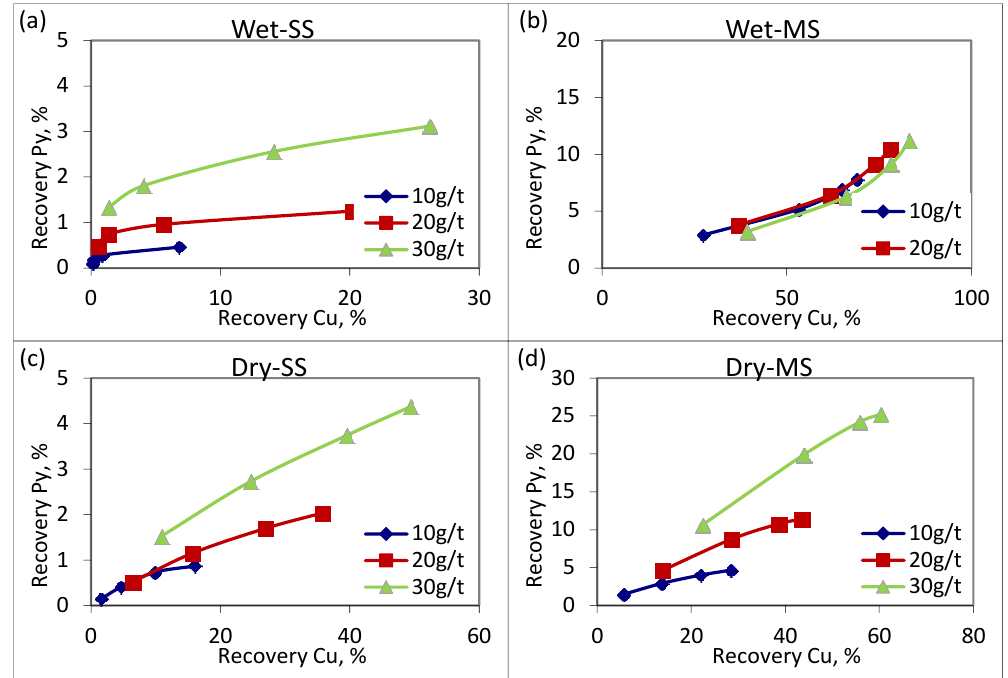
Figure 6. Pyrite vs. copper recovery in flotation after milling conditions of ( a ) Wet-SS ( b ) Wet-MS ( c ) Dry-SS ( d ) Dry-MS.